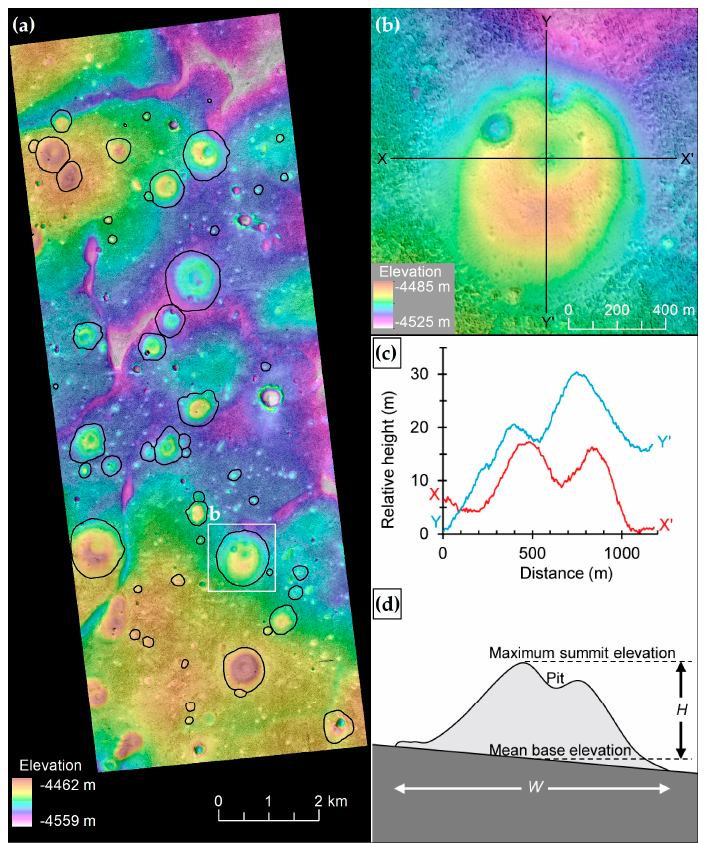
Figure 3. ( a ) Example of a HiRISE-derived DEM (1 m/pix) overlain on a contrast-enhanced orthoimage (1 m/pix), equivalent to Supplementary Figure S11. The solid black lines outline the periphery of each pitted mound that are manually delineated for the measurements of the basal area and average base elevation. ( b ) Close-up indicated in Figure 3a. This mound is equivalent to Mound 12 of Site 11. The black lines (X–X’ and Y–Y’) indicate the location of the topographic profile shown in Figure 2c. North is at the top. ( c ) Topographic profiles across a pitted mound (as shown in Figure 3b). Vertical exaggeration is about 30 times. ( d ) Schematic cross-section of a pitted mound and morphologic parameters measured in this study. H : maximum mound height, W : mound basal width. The vertical scale is highly exaggerated.